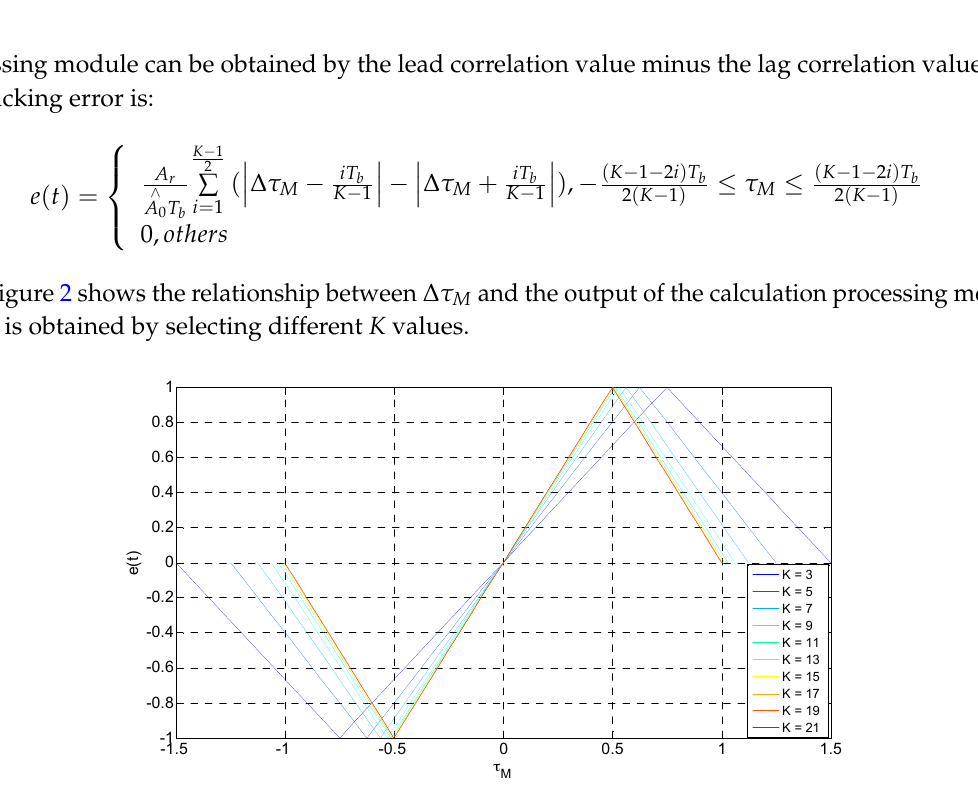
Figure 2. The relationship between the output of the computer processing module and tracking error.